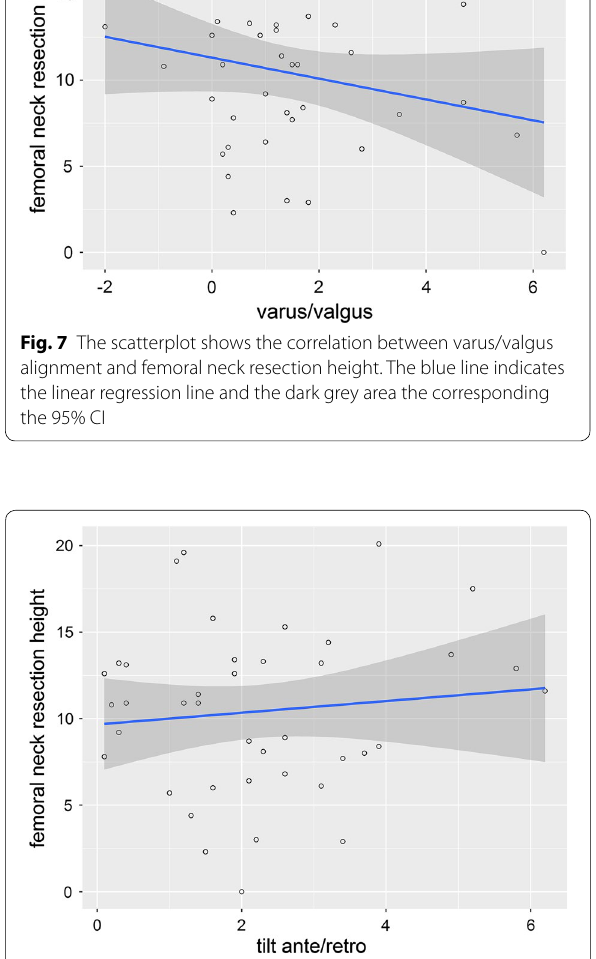
Fig. 8 The scatterplot shows the correlation between implant tilt and femoral neck resection height. The blue line indicates the linear regression line and the dark grey area the corresponding the 95% CI